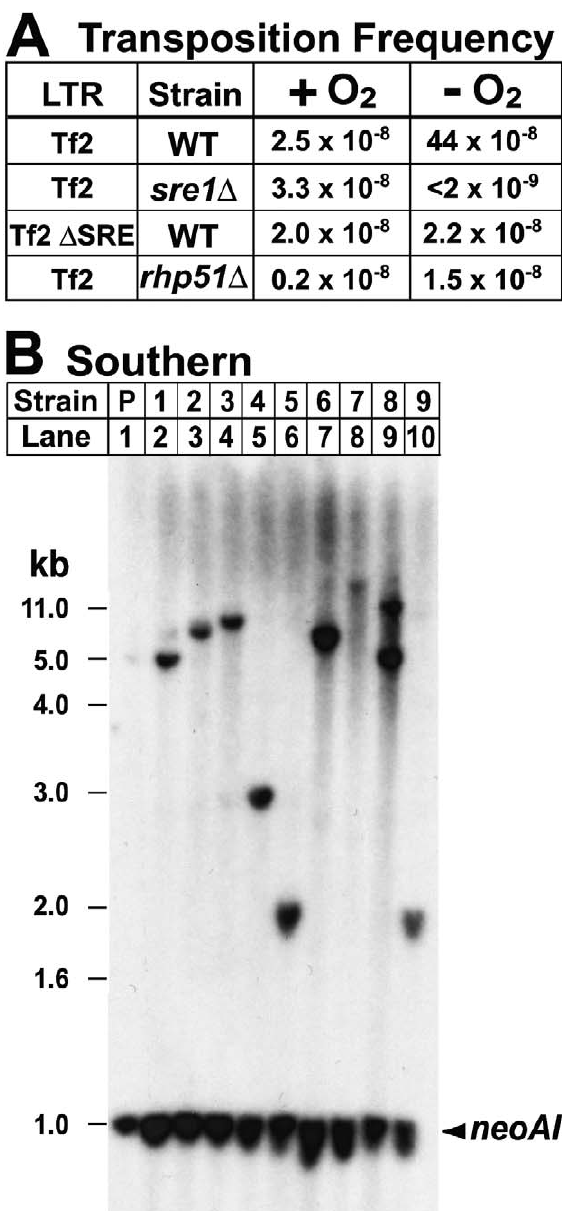
Figure 4. Low Oxygen Stimulates Sre1-Dependent, Tf2 Mobilization (A) Tf2–12- neoAI yeast cells were grown in the absence of oxygen for 8 h to induce transcription, cDNA synthesis, and mobilization. Cells were assayed for acquisition of G418-resistance as described in Materials and Methods. Frequency of G418-resistance for different strains is shown. (B) Genomic DNA was isolated from the parent Tf2–12- neoAI strain (lane 1) and nine G418-resistant progeny strains (lanes 2–10), digested with HindIII, and analyzed by Southern blotting using a neo probe. neoAI denotes the neo gene with the artificial intron present in the Tf2–12- neoAI parent strain.